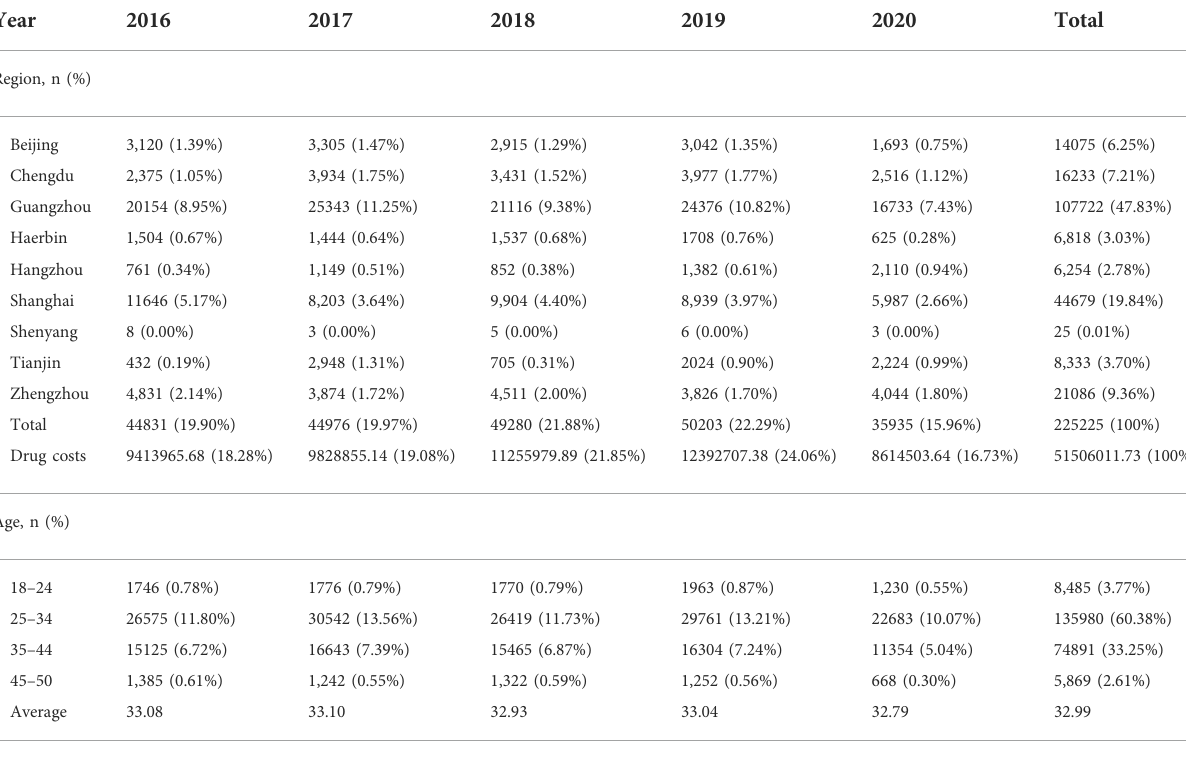
TABLE 1 Demographic characteristics of the patients ( n = 225225).